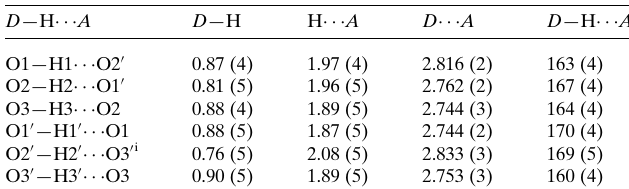
Table 1 Hydrogen-bond geometry (A˚ , (cid:5) ).